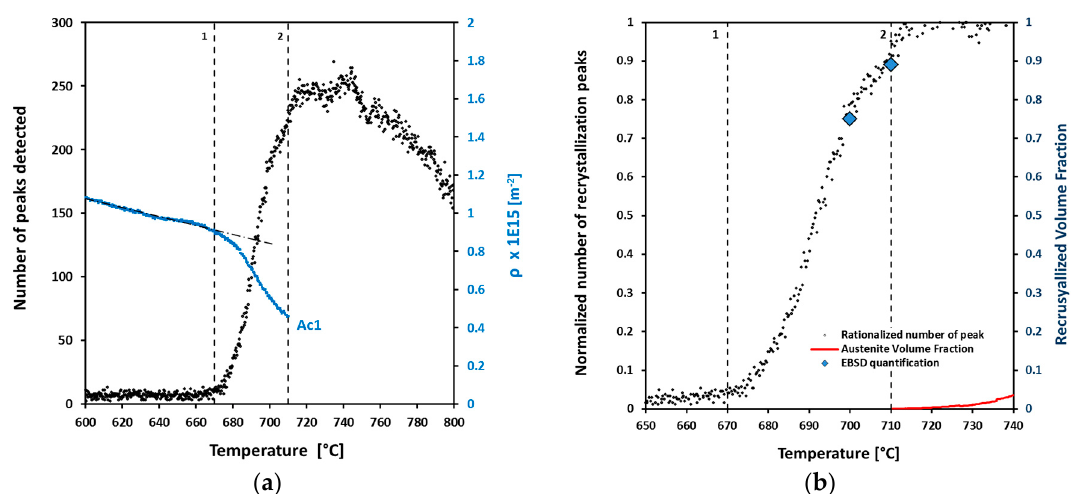
Figure 4. ( a ) Evolution of the number of recrystallization peaks (blue) and of the dislocation density (red) as a function of the temperature. The dotted-dashed line highlights the start of recrystallization. ( b ) Volume fraction of recrystallized ferrite matrix as a function of the temperature (red curve), derived from the counted recrystallization peaks (black dots). The evolution of the austenite volume fraction is reported as well (red curve). On both figures, the black dashed lines labeled 1 and 2 indicate the start of recrystallization and that of austenite transformation, respectively. Blue squares correspond in ( b ) correspond to EBSD measurements presented in Figure 5.